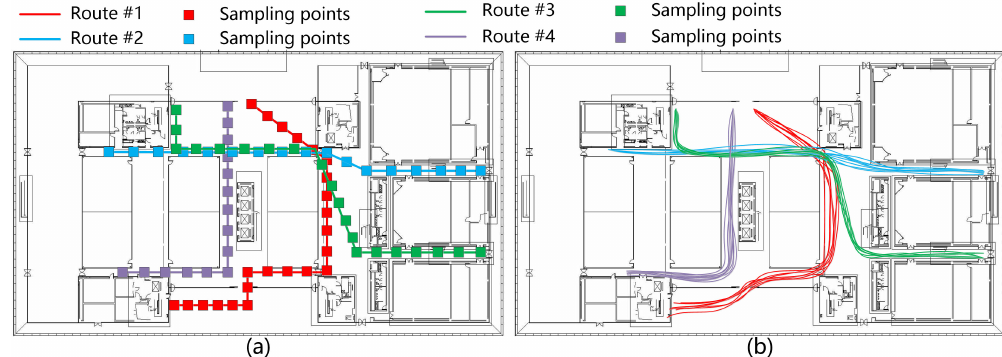
Figure 7. Four represented routes to verify the proposed trajectory restoring method. ( a ) is the ground truth data; ( b ) is the restored trajectories using the proposed